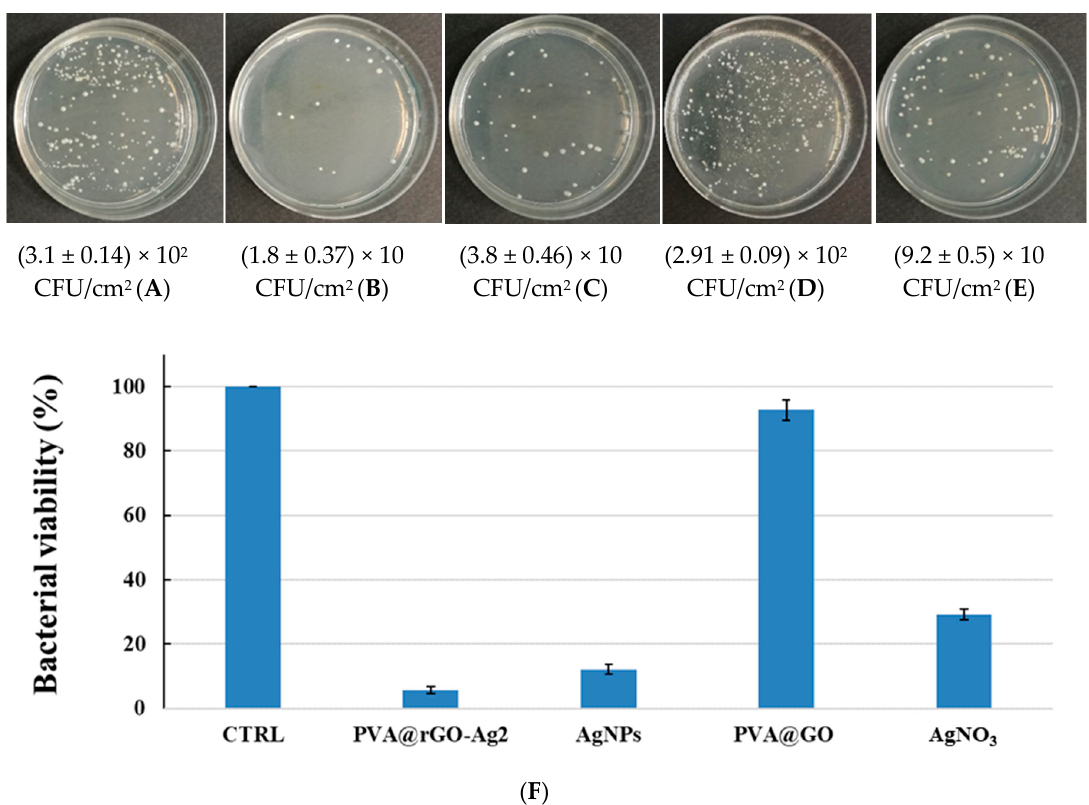
Figure 6. Dynamic Light Scattering (DLS) measurements of GO (black dashed line), PVA (grey line), PVA@GO (black line), and PVA@rGO-Ag1 (red line) in water (samples concentration 12.5 μ g/mL).